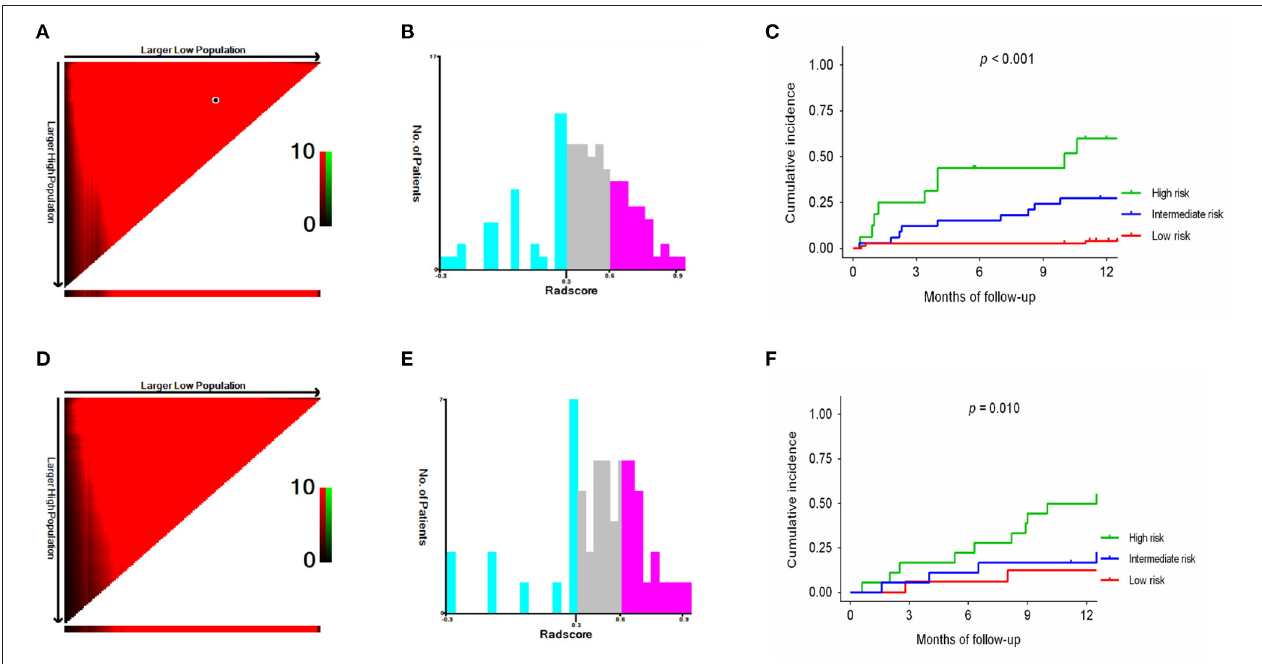
FIGURE 5 | X-tile analysis of the total Rad-score Liver − Spleen and survival curves stratified by the score calculated by the Rad-score Liver − Spleen in the training (A–C) and validation (D–F) cohorts.